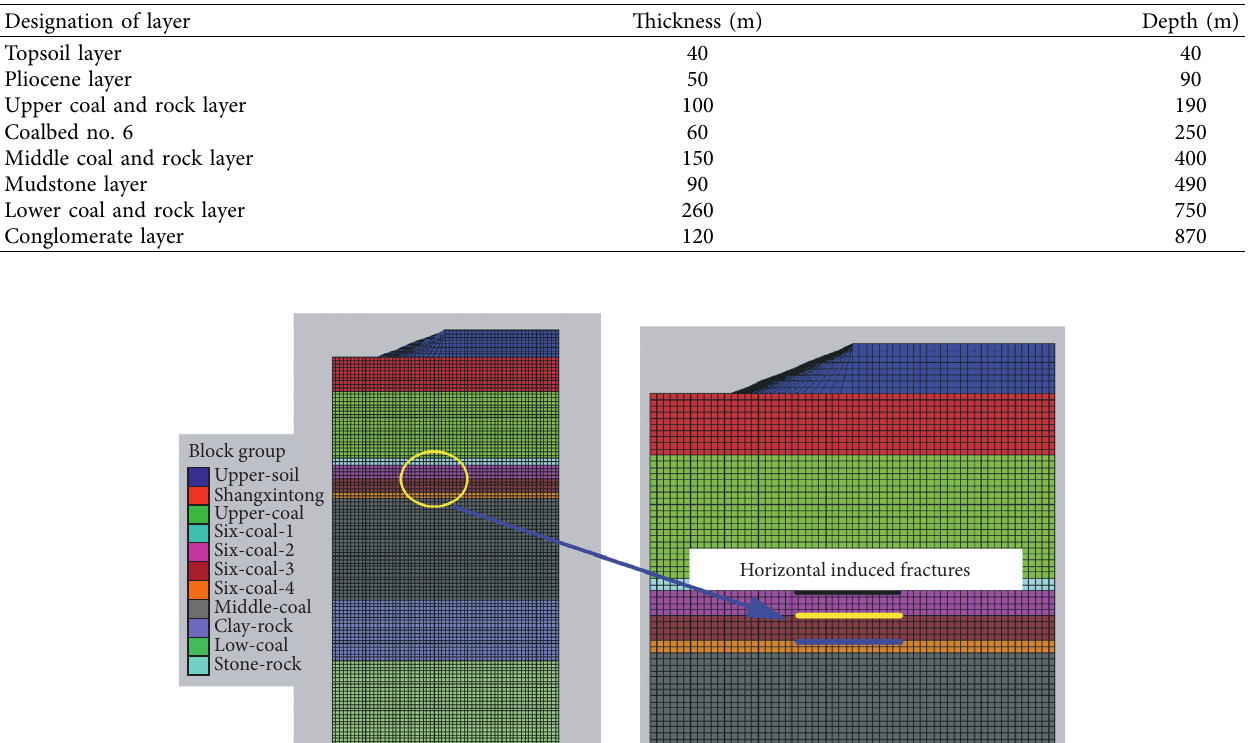
Table 2: Geometric parameters of the model.